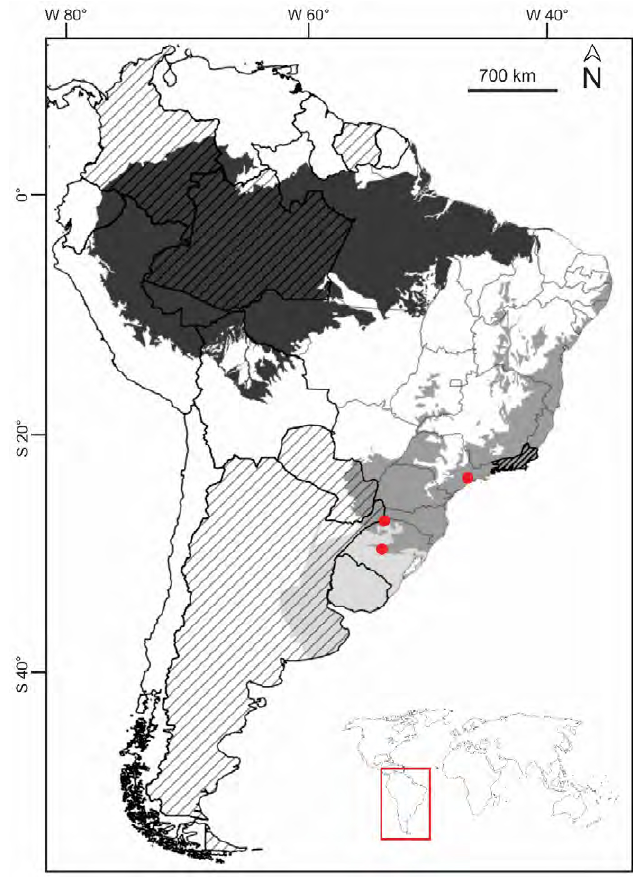
Figure 1. Distribution map of Dinidor mactabilis showing political divi- sion and biomes with species occurrence points. Shaded areas represent biomes: dark gray (Amazonia), medium gray (Atlantic Forest) and light gray (Pampa). Dashed areas represent states or countries with reported records on literature where specific locations are not informed. Red dots are the only records at the municipality